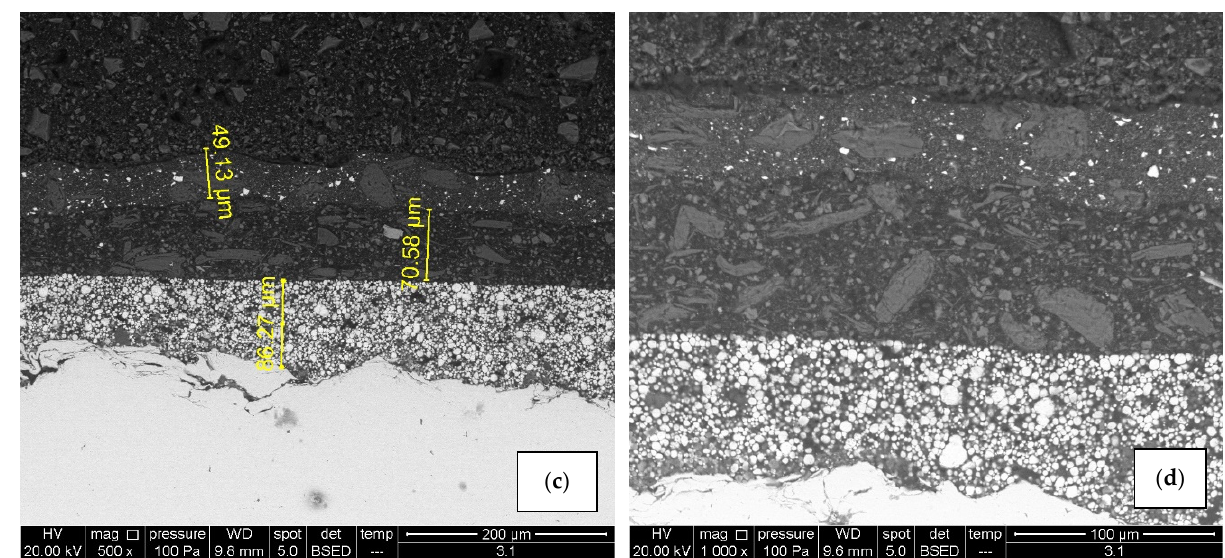
Figure 10. SEM micrographs of air ‐ dried sample A1 ( a , b ) and IR ‐ dried sample A2 ( c , d ), 500× and 1000× magnification. There are no visible signs of cracks and pores, adhesion is good and zinc is uniformly scattered in the primer.